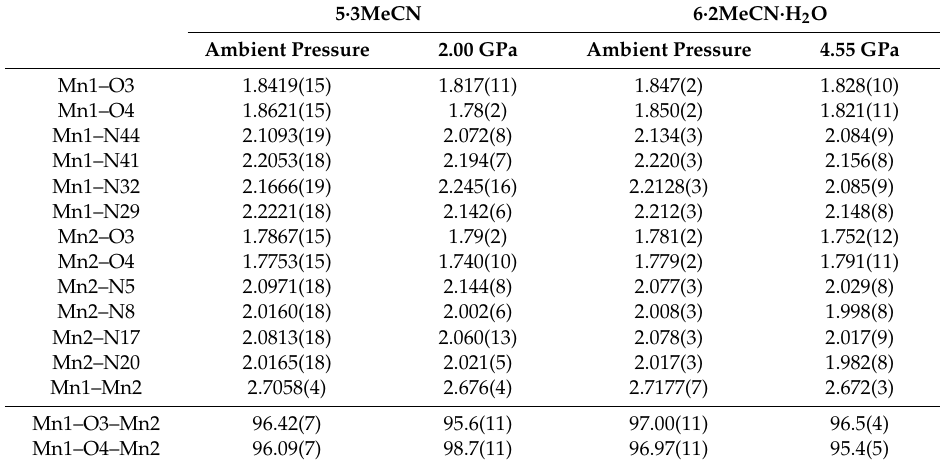
Table 5. Selected bond lengths (Å) and angles ( ◦ ) for 5 · 3MeCN and 6 · 2MeCN · H 2 O at ambient and maximum